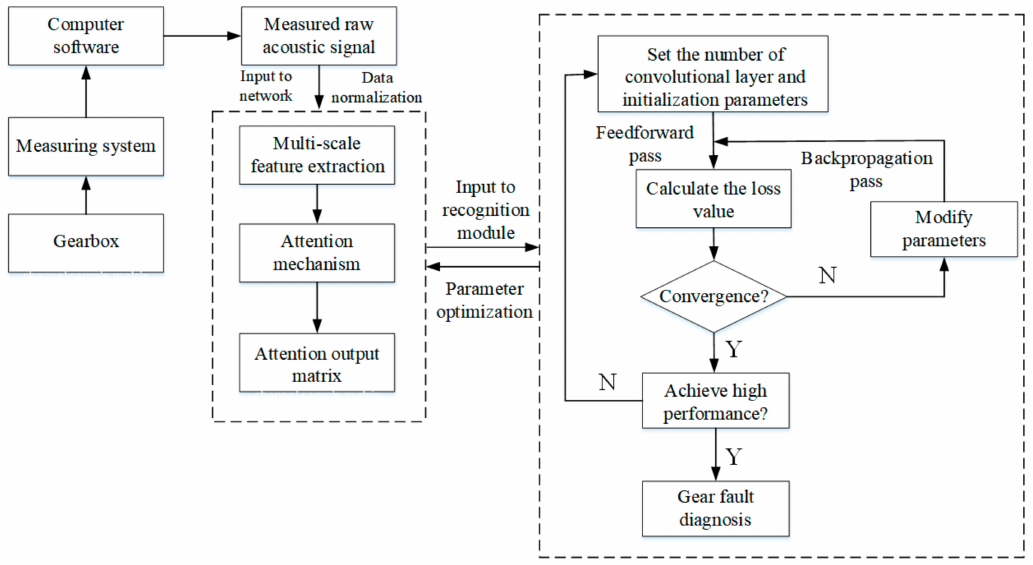
Figure 1. Block diagram of the proposed method.